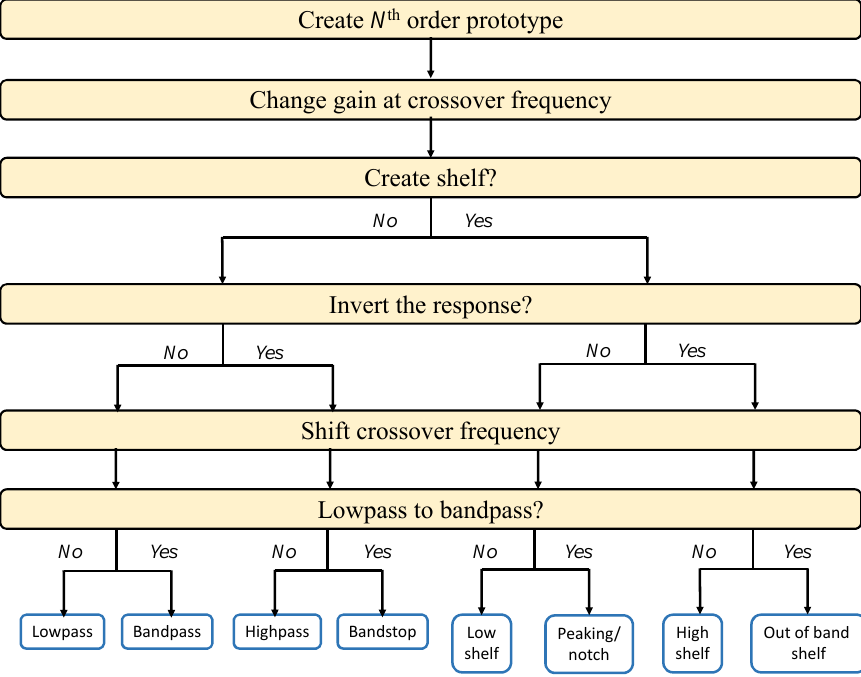
Figure 6. Flow diagram of design technique for high order IIR filters. Starting with a simple N th